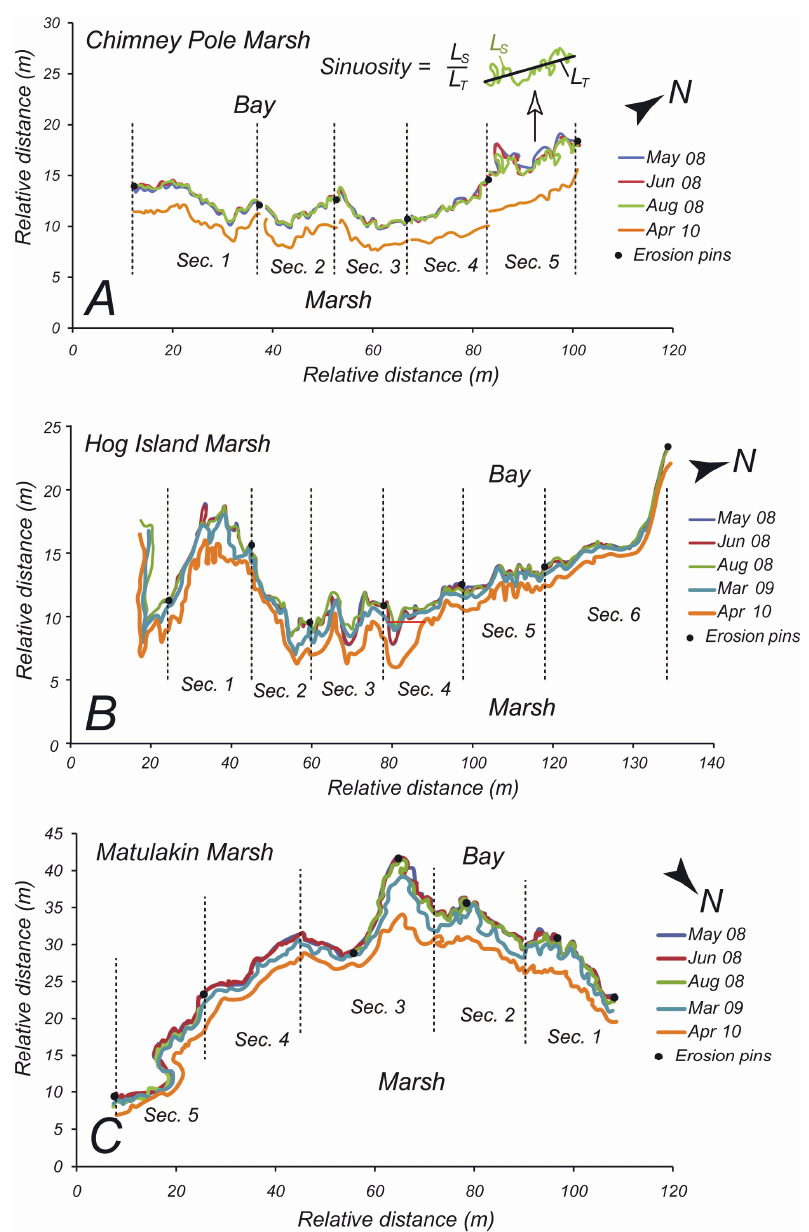
Figure 3. High resolution surveys of marsh boundaries in Hog Island Bay between 2008 and 2010. ( A ) Chimney Pole Marsh; ( B ) Hog Island Marsh; ( C ) Matulakin Marsh. The vertical scale is distorted to better appreciate variations in boundary sinuosity. An example of boundary sinuosity calculation is reported in ( A